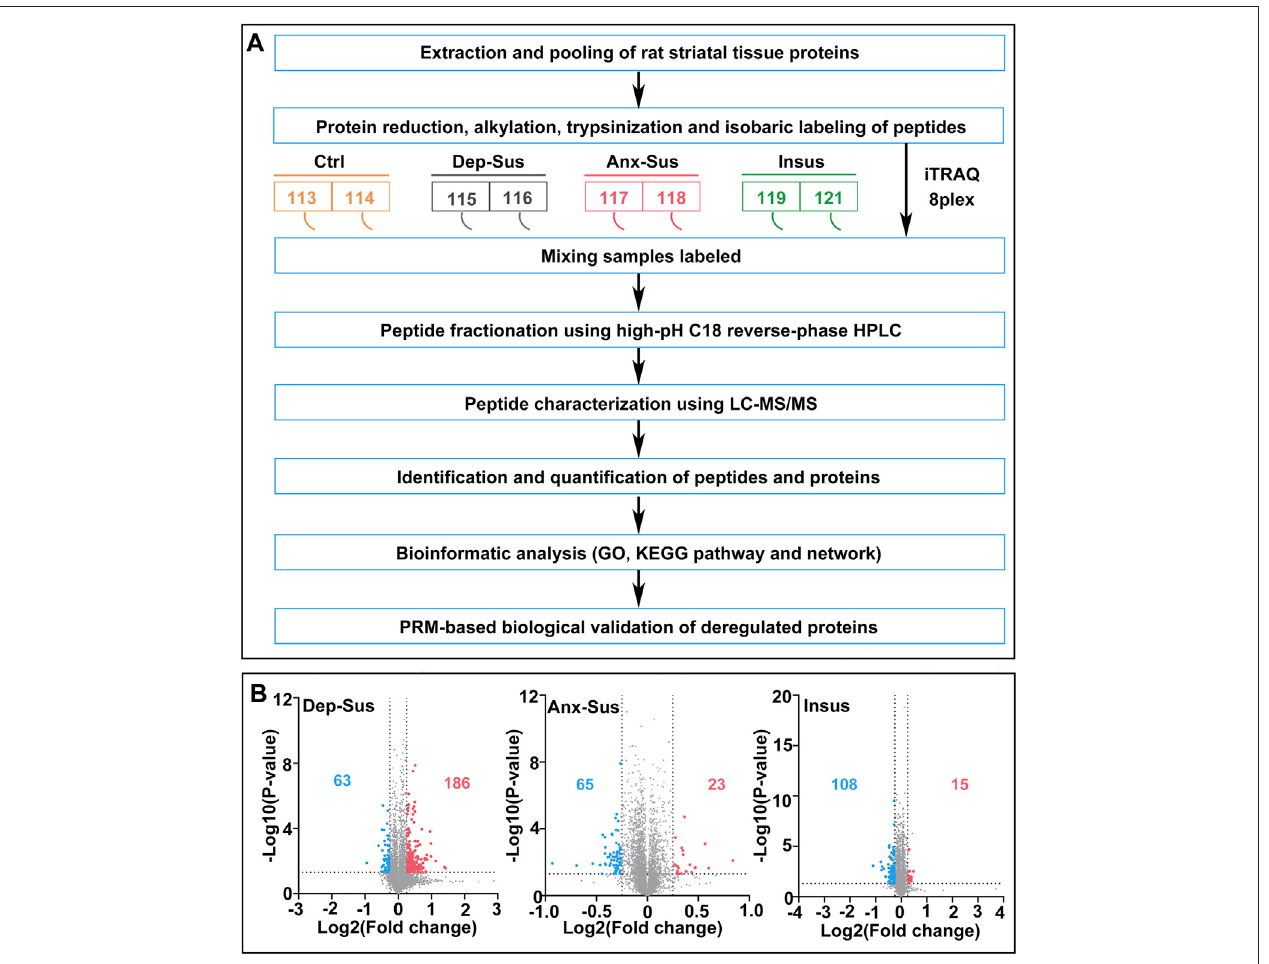
FIGURE 1 | Comparative proteomic analysis of the striatum in the CMS model rats. (A) Flow diagram of quantitative proteomics. The striatal tissue samples from the four groups [including depression-susceptible (Dep-Sus), anxiety-susceptible (Anx-Sus), insusceptible (Insus), and control (Ctrl)] were used. (B) Volcano plots of abnormally expressed proteins in the three stressed groups. Blue spots represent downregulated proteins, and red spots represent upregulated proteins. Gray spots represent nondifferentially expressed proteins.